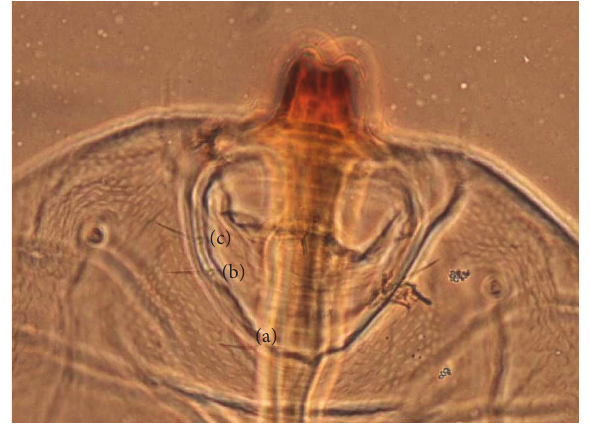
Figure 26: Retracting the head into the neck segment juxtaposes the dorsal setae of the prothorax, three on each side ((a), (b), (c)) onto a fold collaring the